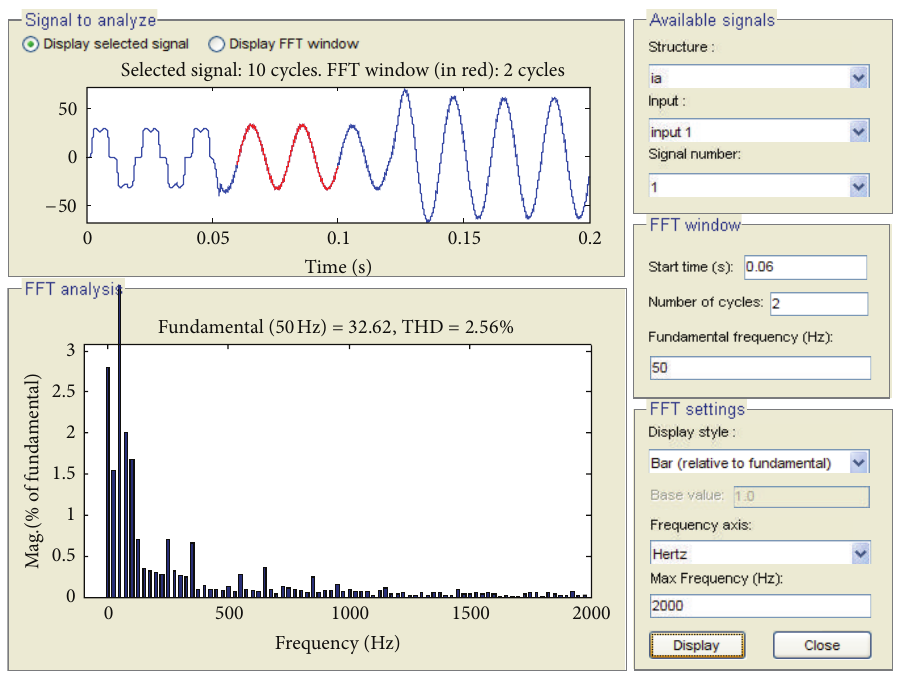
Figure 6: Current harmonic analysis from 0.06 to 0.1